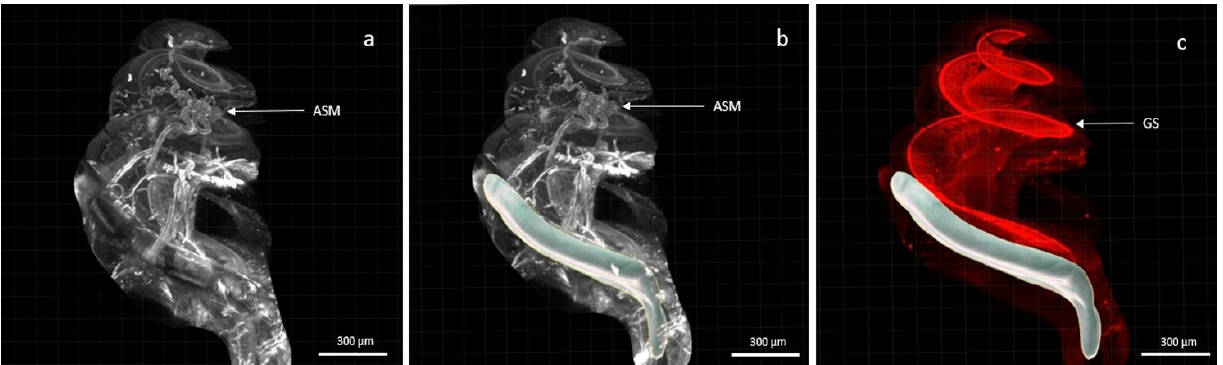
Figure 4. Cochlea with the electrode array in situ. ( a , b ) showed labelling of fibroblasts and arterioles by alpha SMA; ( c ) showed labelling of type 1 neurons in the spiral ganglion by NaKATPase alpha 3. In ( b , c ) the electrode array was modelled using Imaris software. (Scale 300 μ m, 4× objective).